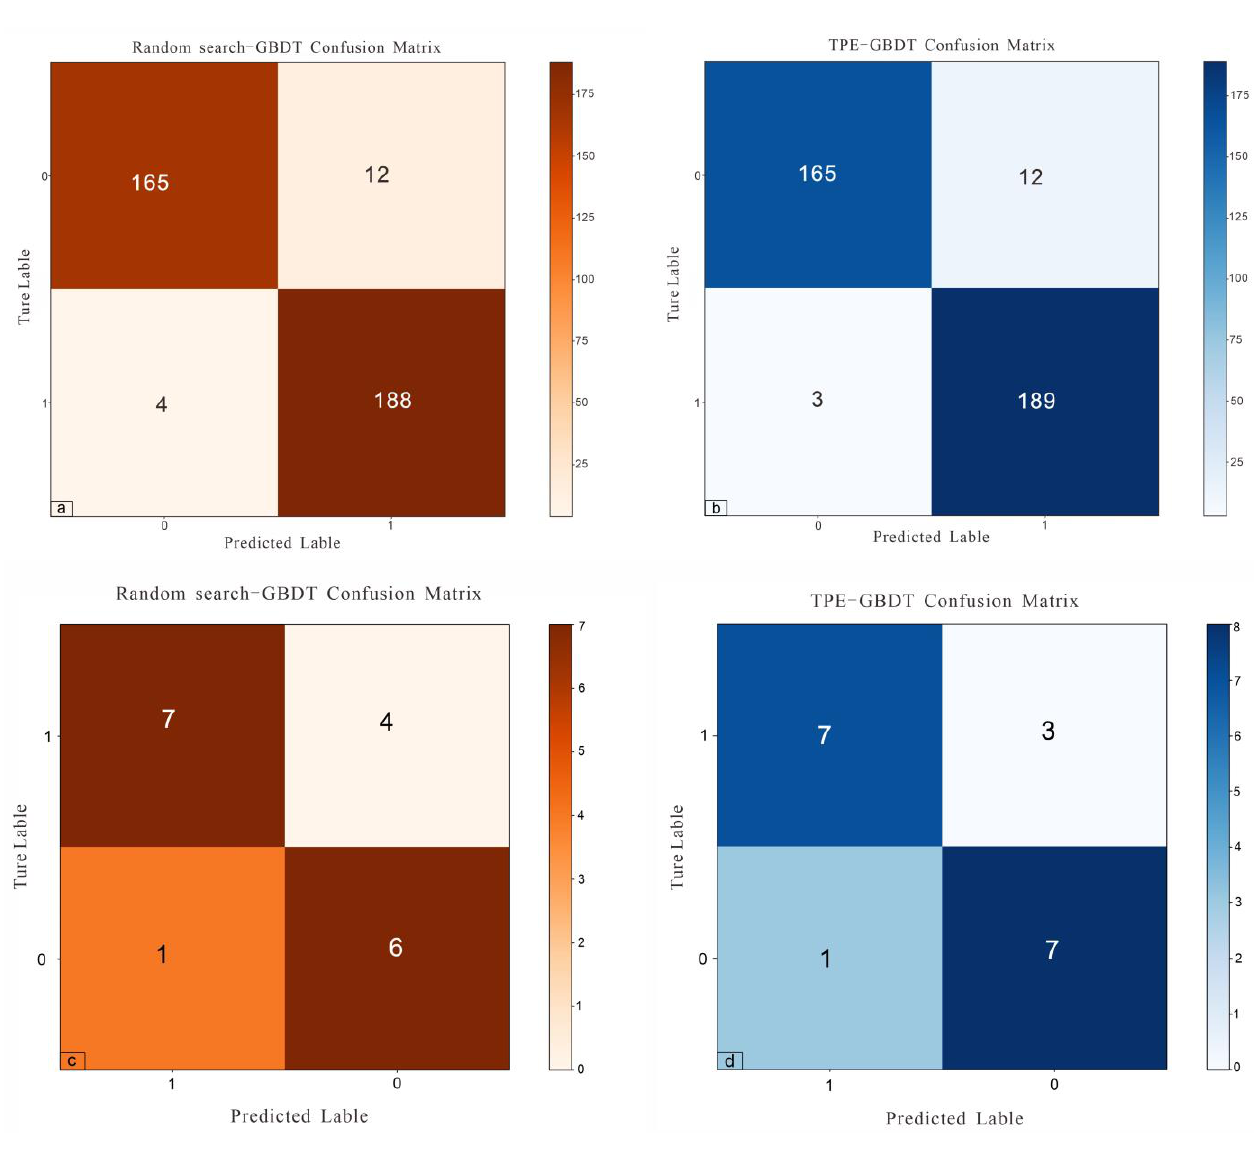
Figure 9. The confusion matrix of the: ( a ) random search-GBDT; ( b ) TPE-GBDT model with the MS datasets; ( c ) random search-GBDT; and ( d ) TPE-GBDT model with the OS datasets. Table 6. The secondary indicators of the GBDT model base on the confusion matrix. Model